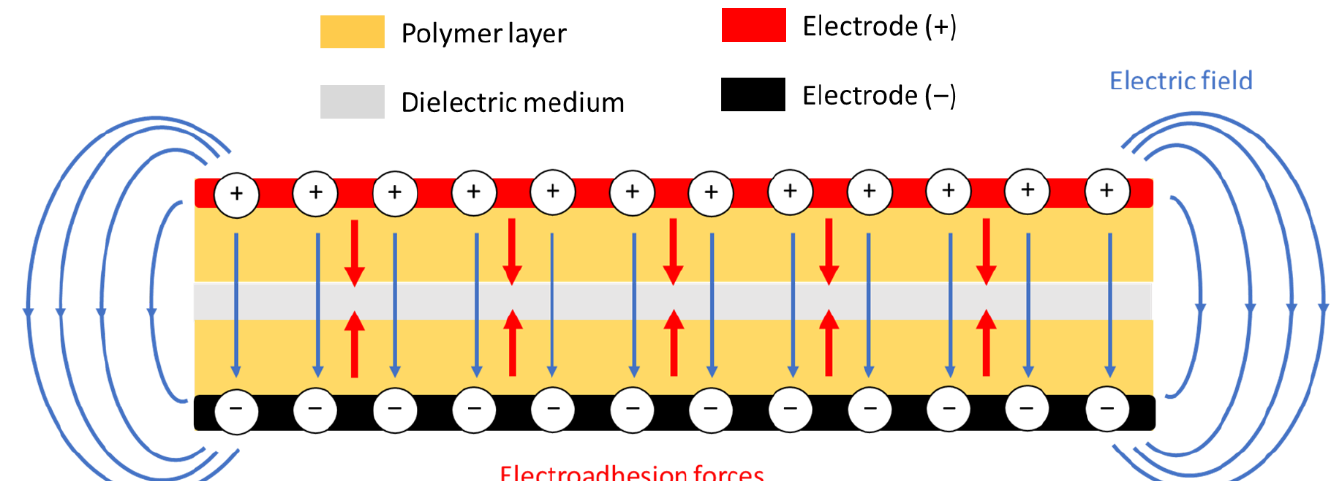
Figure 1. Mechanisms of Electroadhesion.